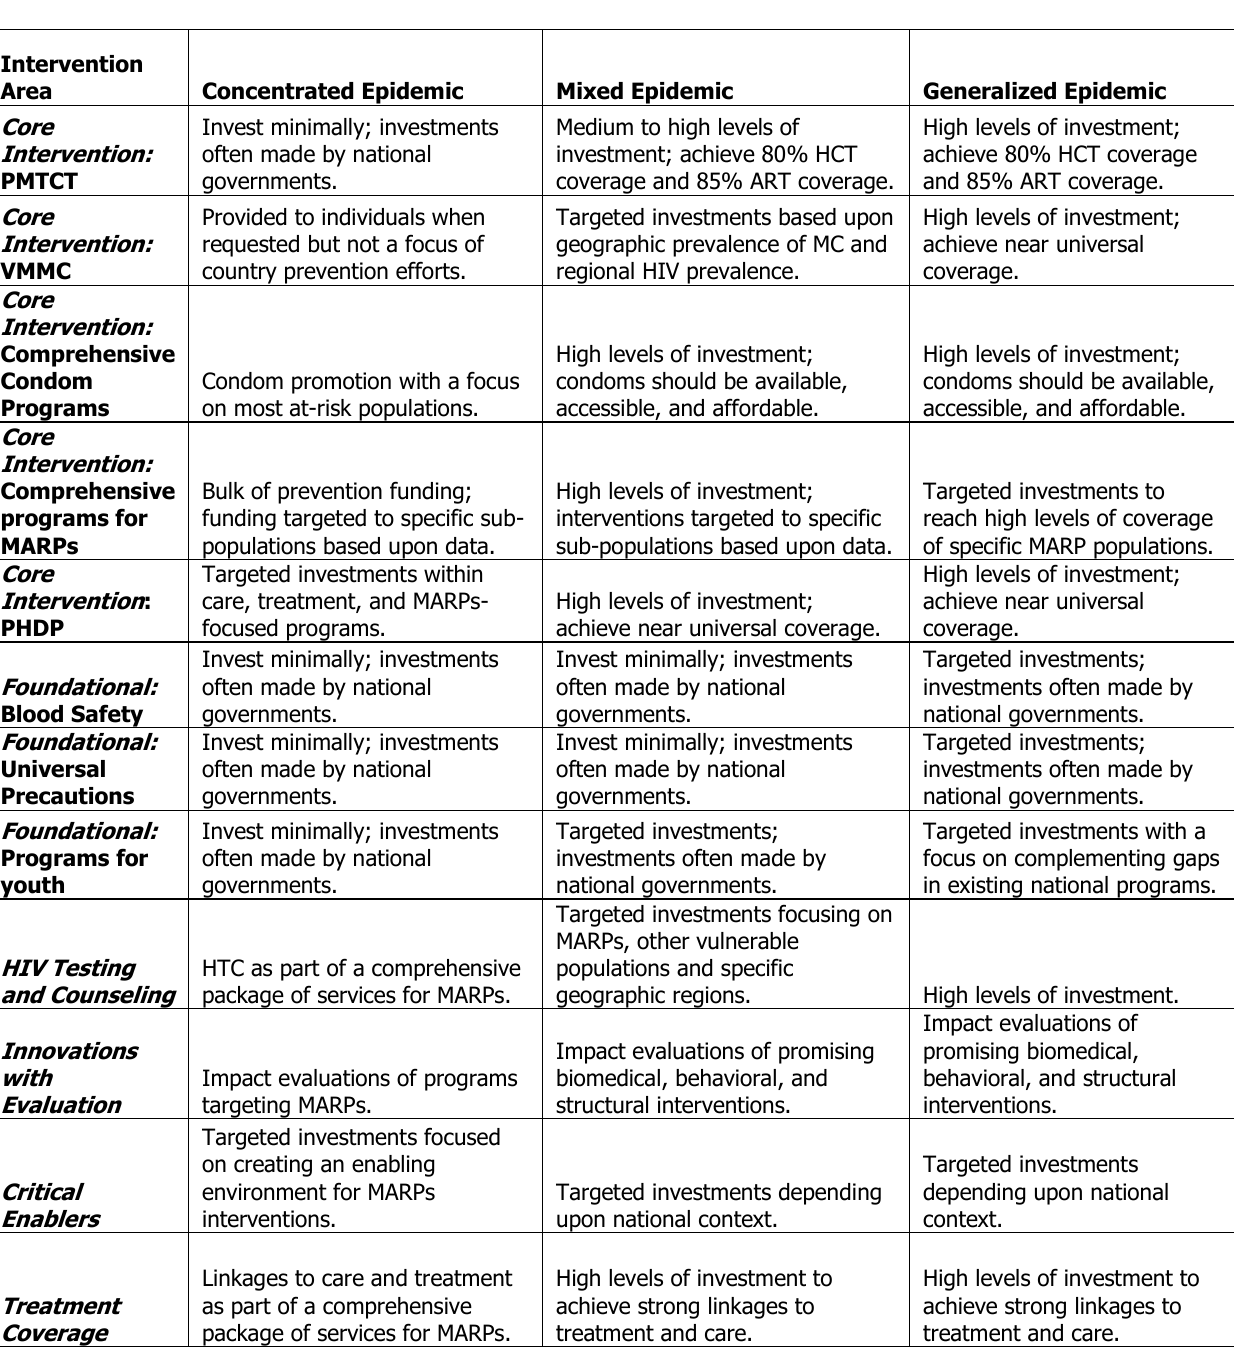
Table 1: Examples of how to apply prevention priorities across different